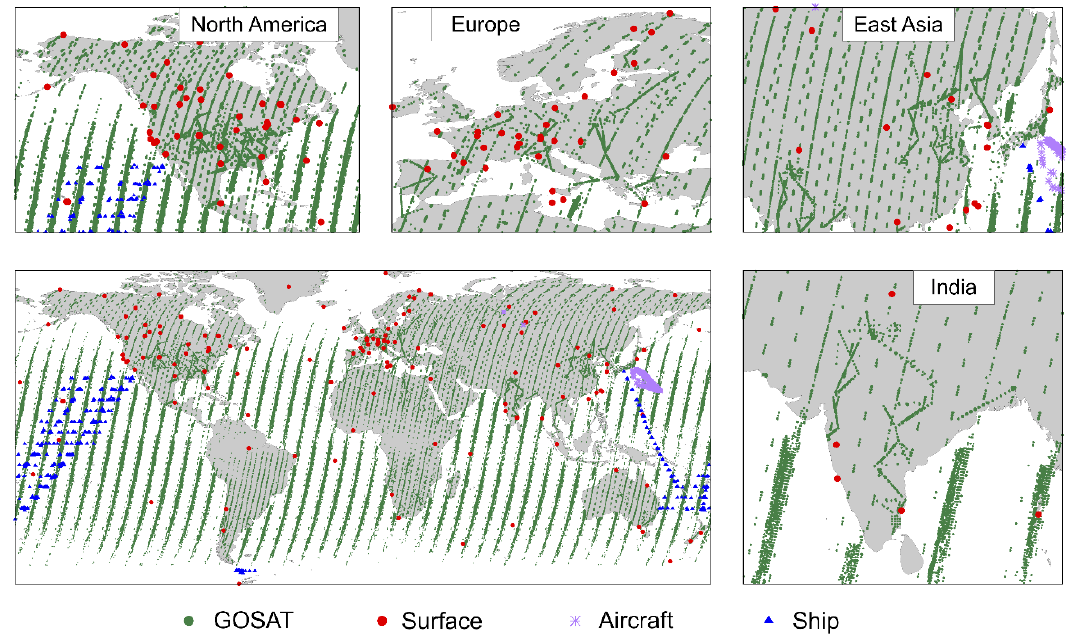
Figure 1. Locations of the methane observations used in the inversion. Greenhouse gas Observing Satellite (GOSAT) (green), surface station (red), aircraft (purple), and ship observations (blue) are shown. The top row and right columns are regionally zoomed from the bottom left panel.